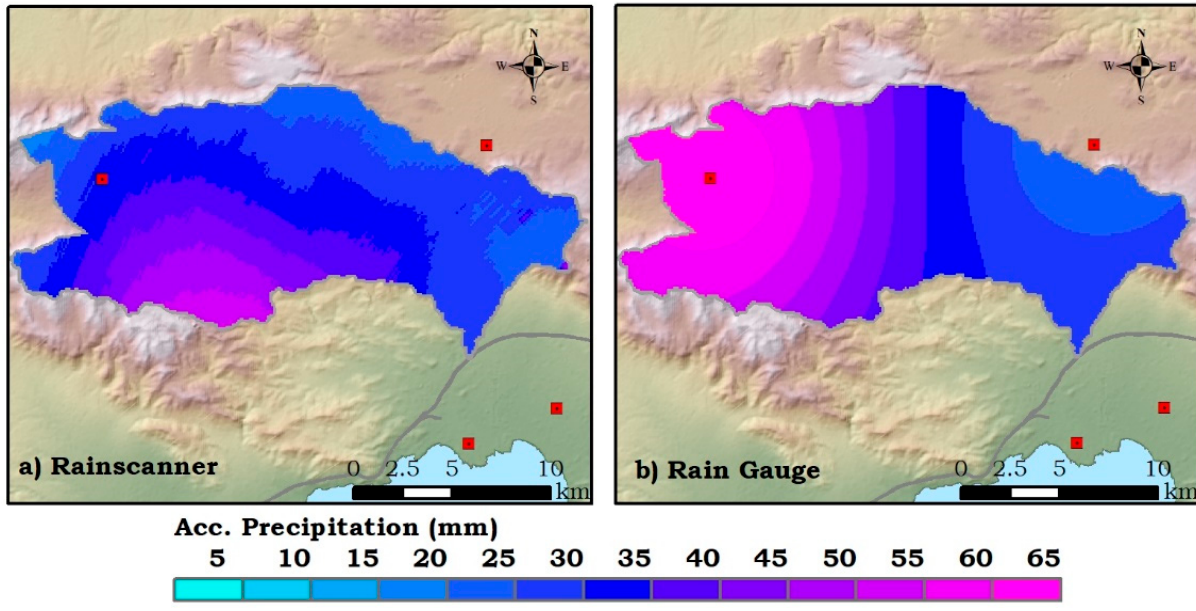
Figure 5. Accumulative precipitation, ( a ) rainscanner estimates through Z = 200 R 1.6 , ( b ) rain gauges through IDW.